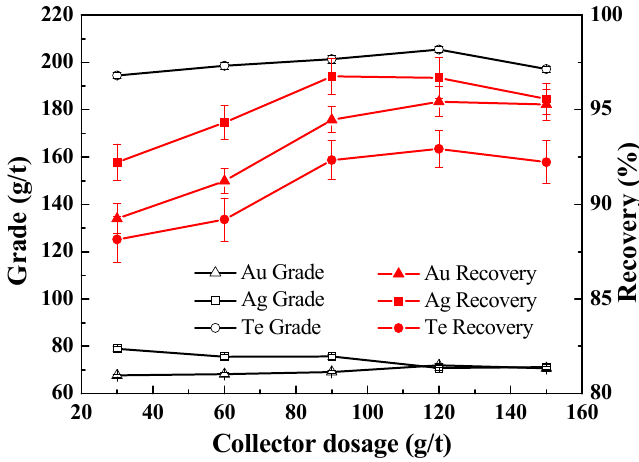
Figure 5. Flotation recovery and grade of Te, Au, and Ag as a function of collector dosage value (content of − 0.074 mm (70%); pulp density: 33%; pulp pH: 8; combined collector: sodium isoamyl xanthate + ethyl thiocarbamate (1:1)).